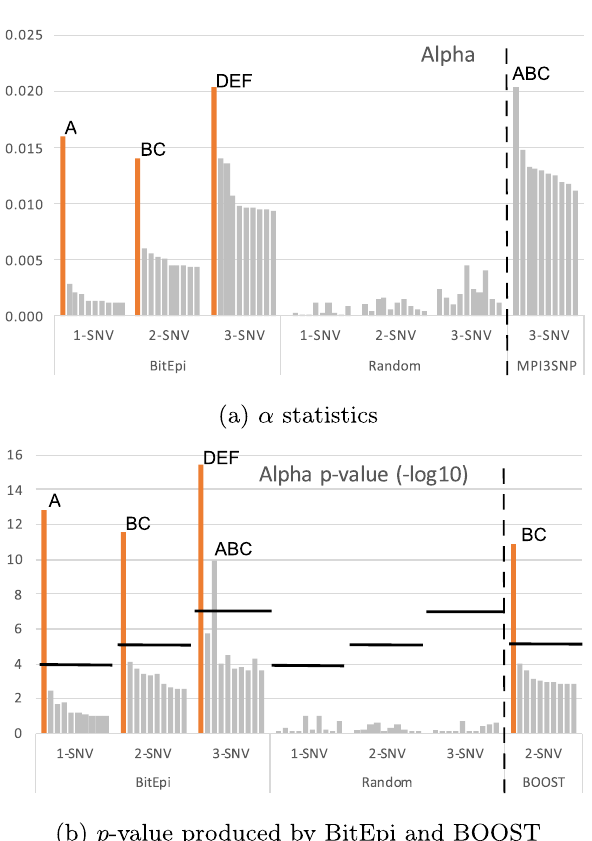
Figure 4. Compare detection power of BitEpi with BOOST and MPI3SNP for 2-SNV and 3-SNV analysis.